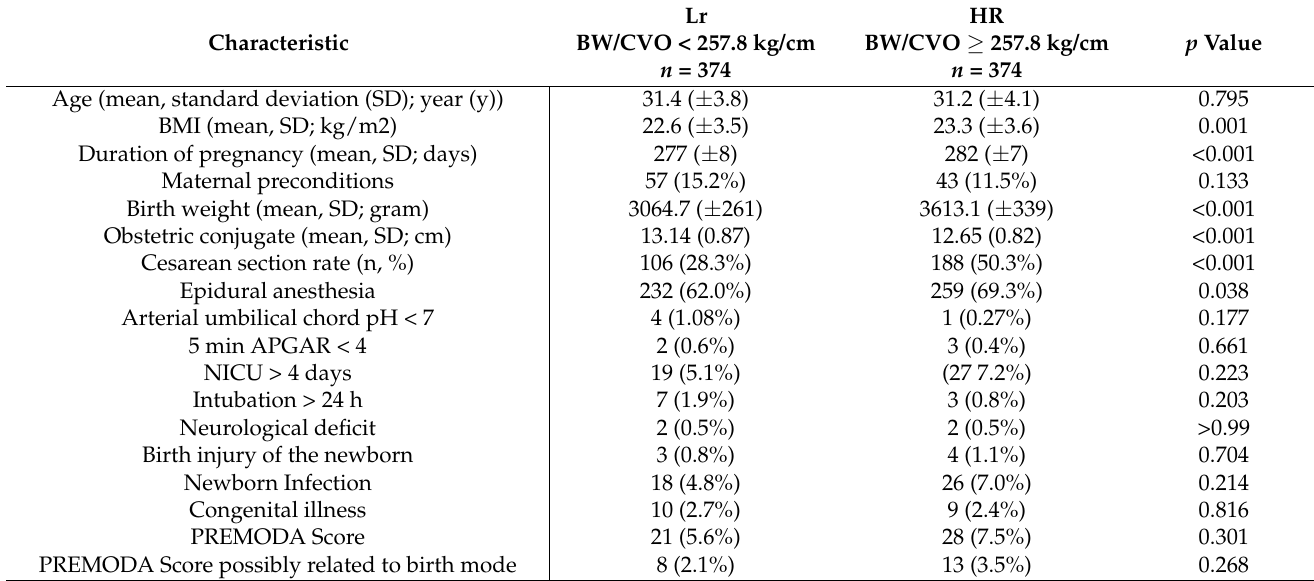
Table 1. Vaginally intended deliveries–Outcom in low ratio Group (LR) and high ratio group (HR).